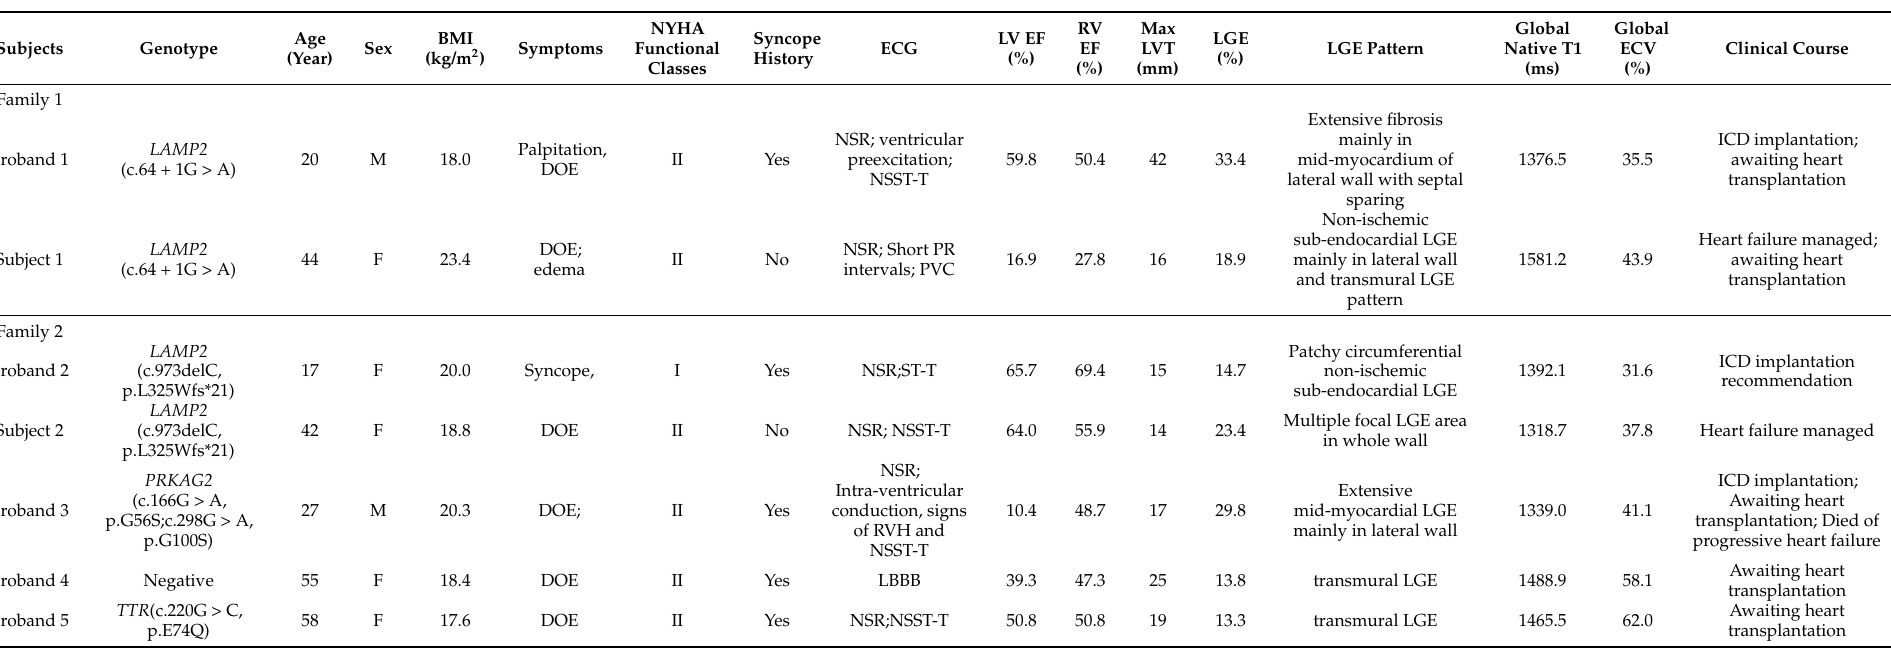
Table 1. Demographic, clinical, electrocardiogram and cardiac MRI-phenotypic characteristics of the rare disease patients with HCM